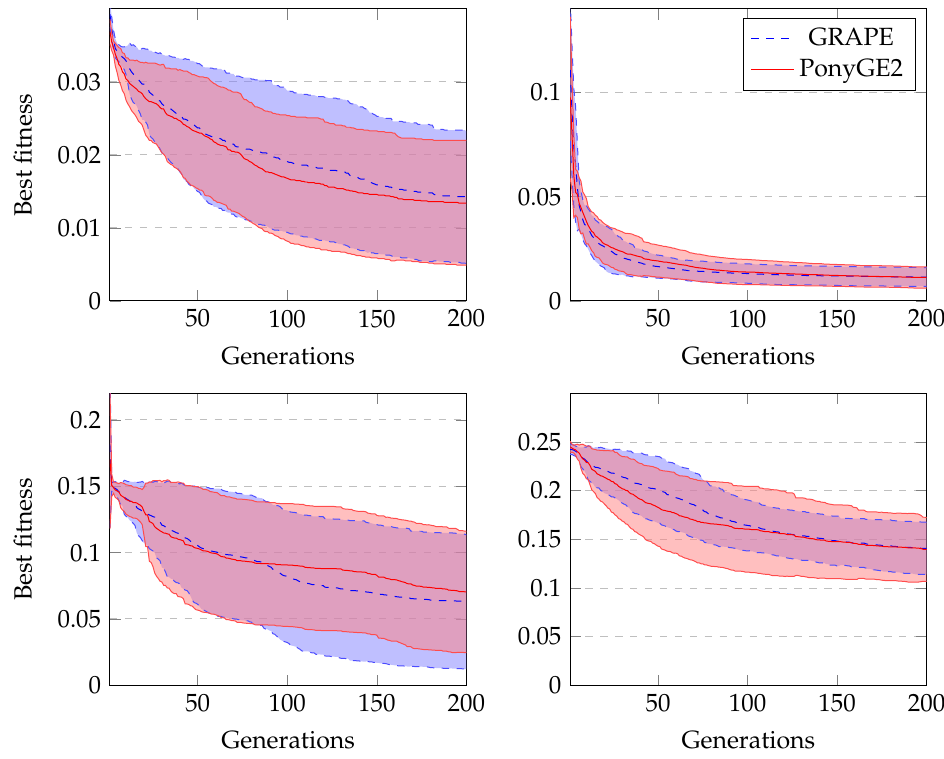
Figure 4. Average fitness of the best individual across generations using GRAPE and PonyGE2: Vladislavleva-4 ( top left ), Pagie-1 ( top right ), Banknote ( bottom left ) and Heart Disease ( bottom right